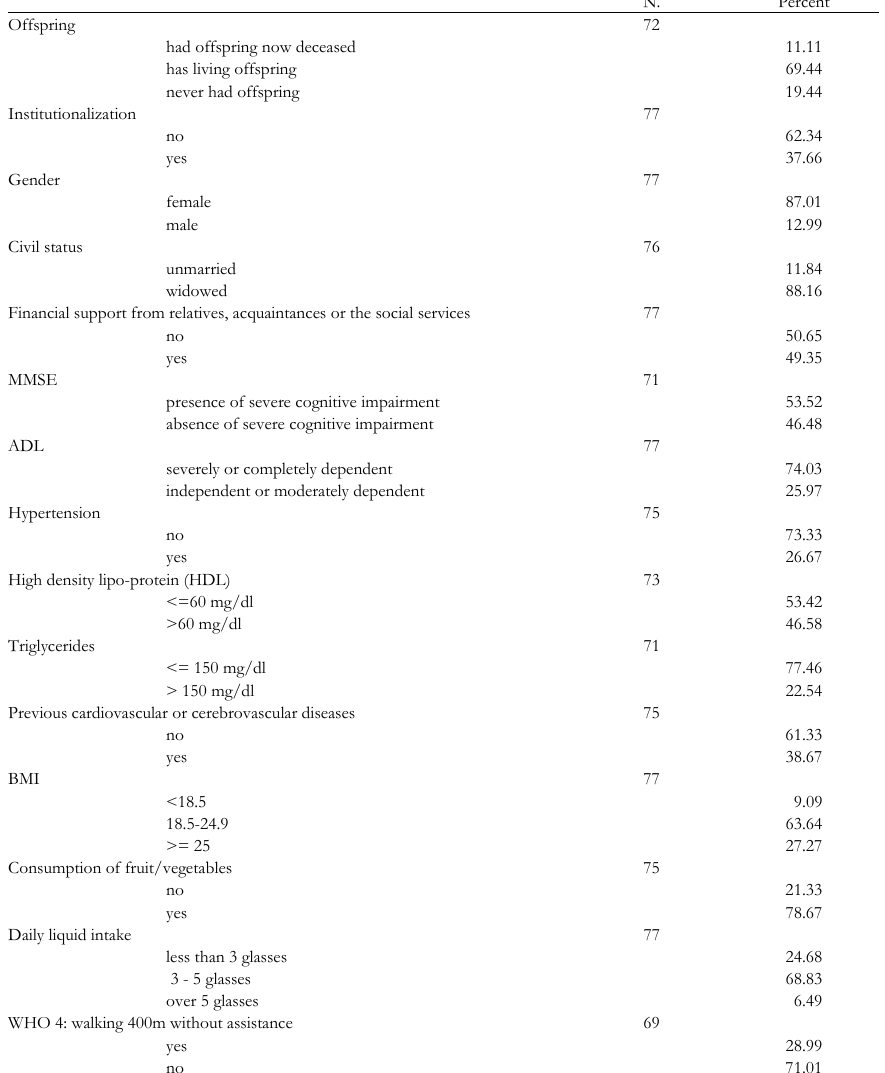
Descriptive statistics for qualitative